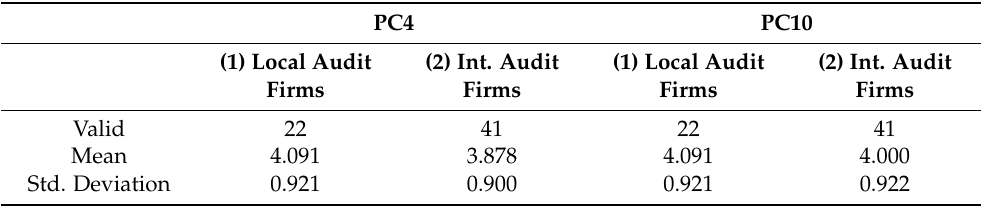
Table 5. Descriptive statistics for survey items of perceived contributions.